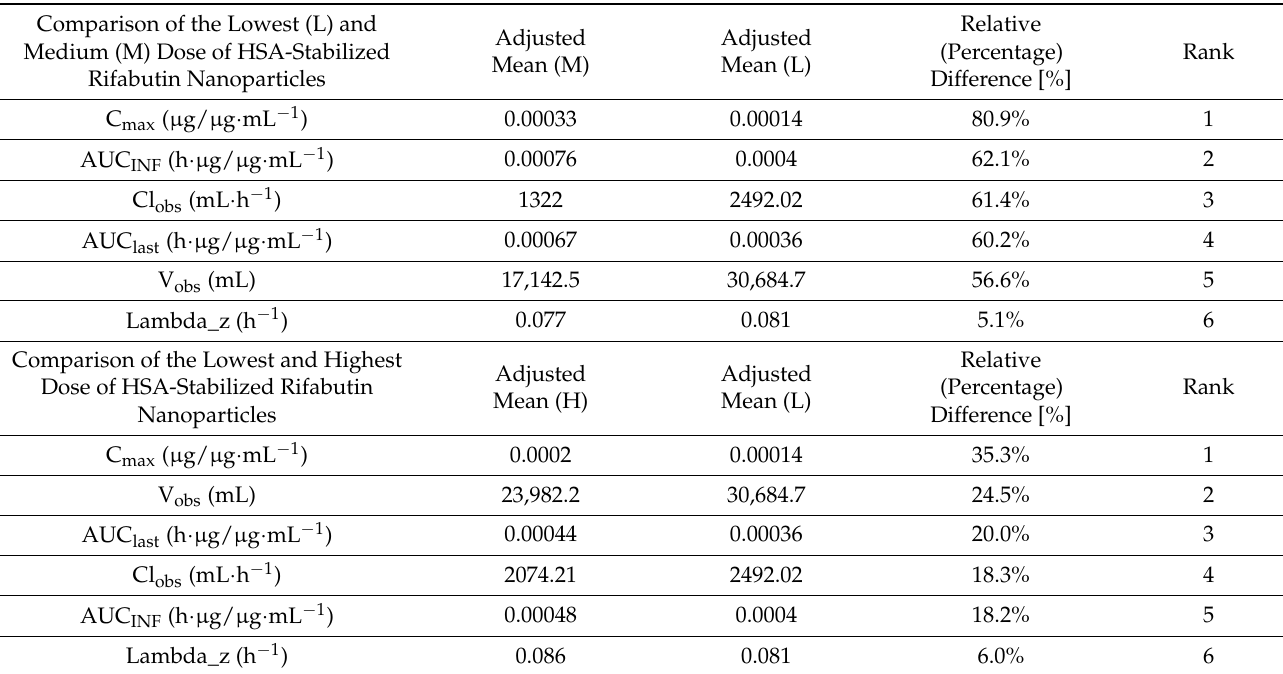
Table 4. NCA evaluation of the pharmacokinetics of HSA-stabilized rifabutin nanoparticles in rabbits ( n = 5) using the PKanalix bioequivalence module. The different dose strengths were compared based on the dose fractions per